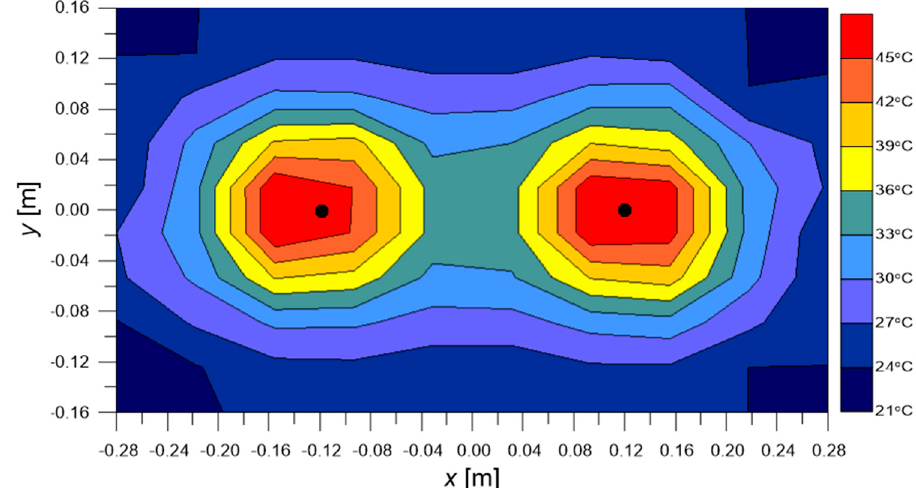
Figure 14. Temperature maps on the x - y plane determined on the basis of experimental results.